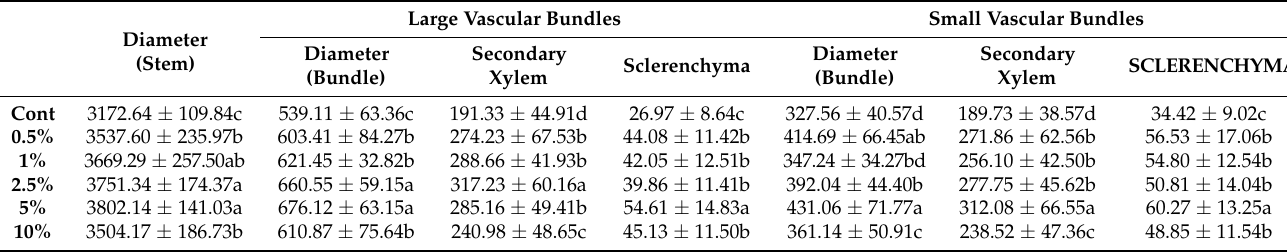
Table 1. Impact of different concentrations of fermented alfalfa brown juice (BJ) on some characteristics of the stem tissue of French marigold ( µ m) (mean ± standard deviation, n = 45). Diameter